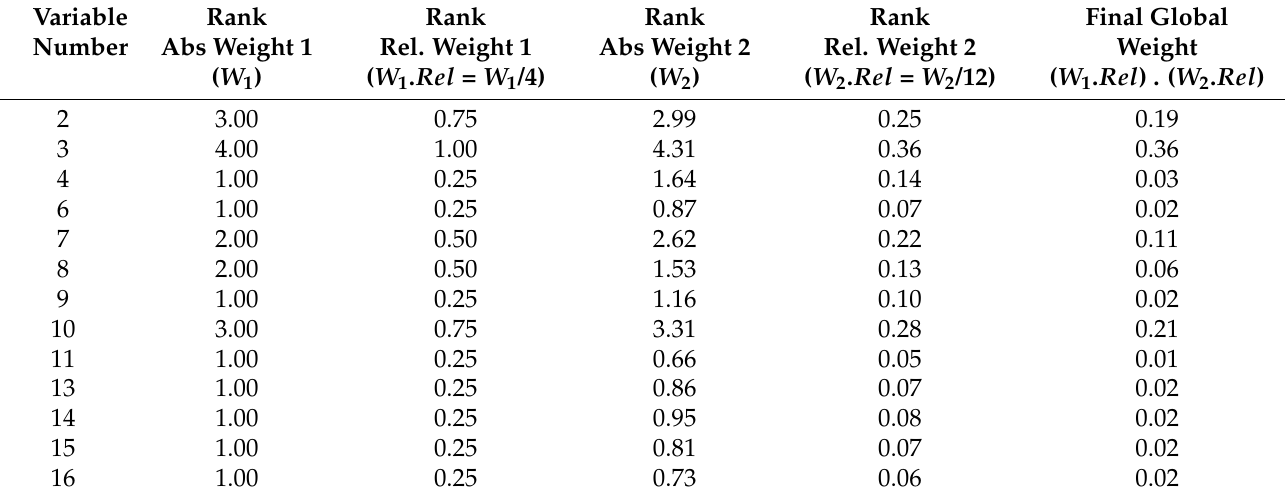
Table 5. Most Important Variables—Weights